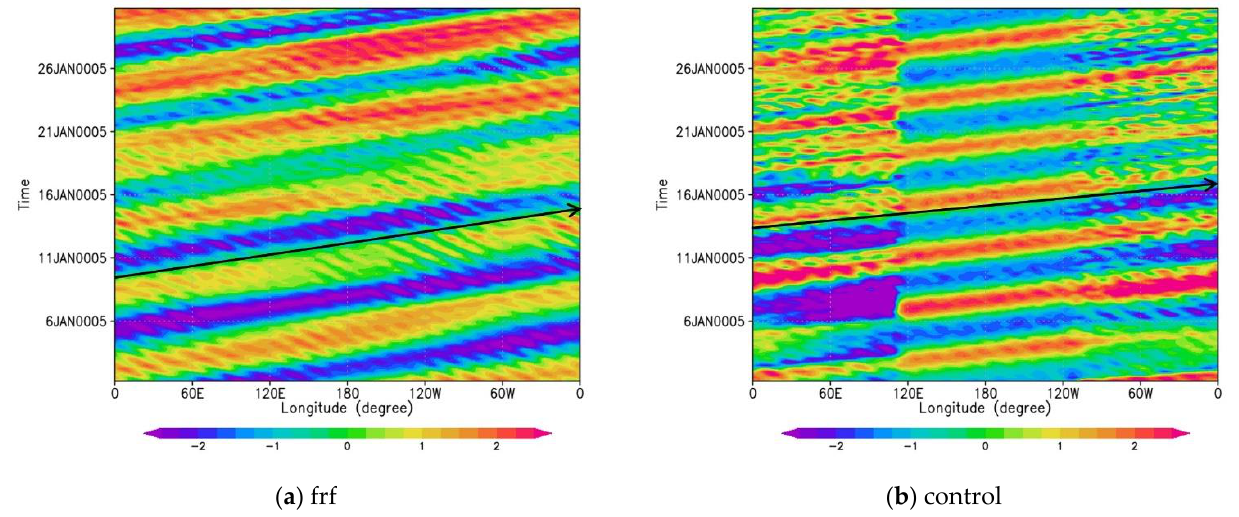
Figure 2. Longitude–time cross-sections of zonal wind (m/s) deviation from its time average from 1 January, 5th year at 70 km and the equator for the ( a ) frf and ( b ) control cases. Black arrows indicate periods of ~5 and ~4 Earth days for ( a ) and ( b ),